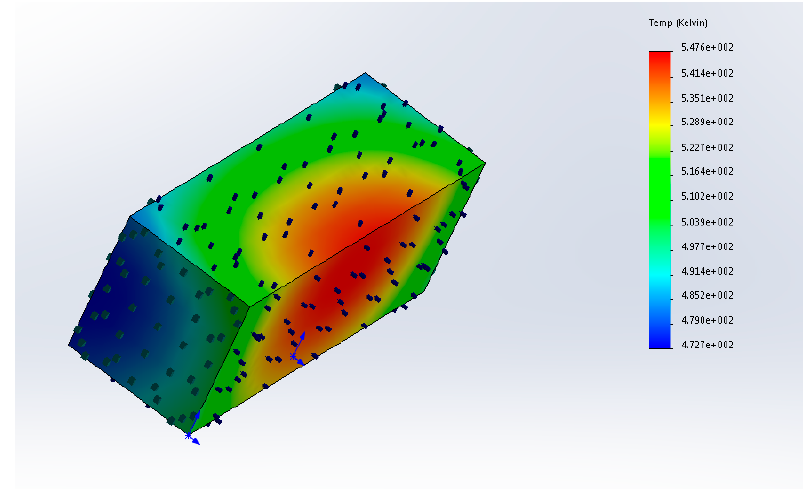
Figure 54. Initial Steady-state Simulation Results end of the Heating Phase.